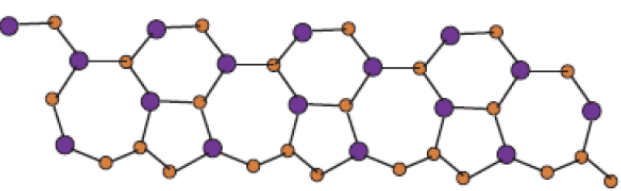
Figure 2. Si 2 C 3 I [ r, s ] for r = 4, s = 3